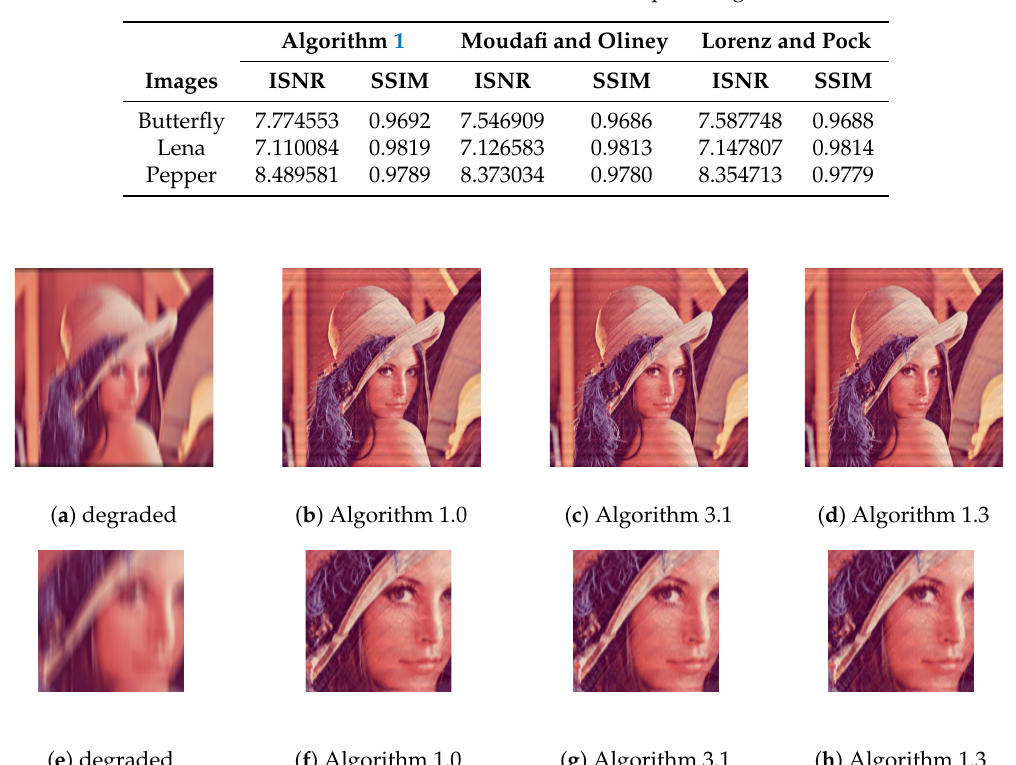
Table 1. The ISNR and SSIM values of the compared algorithms.